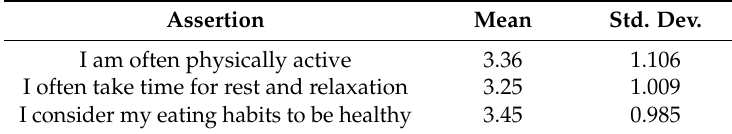
Table 2. Health activities self-assessment (scale: 1—disagree, never; 5—agree, often).